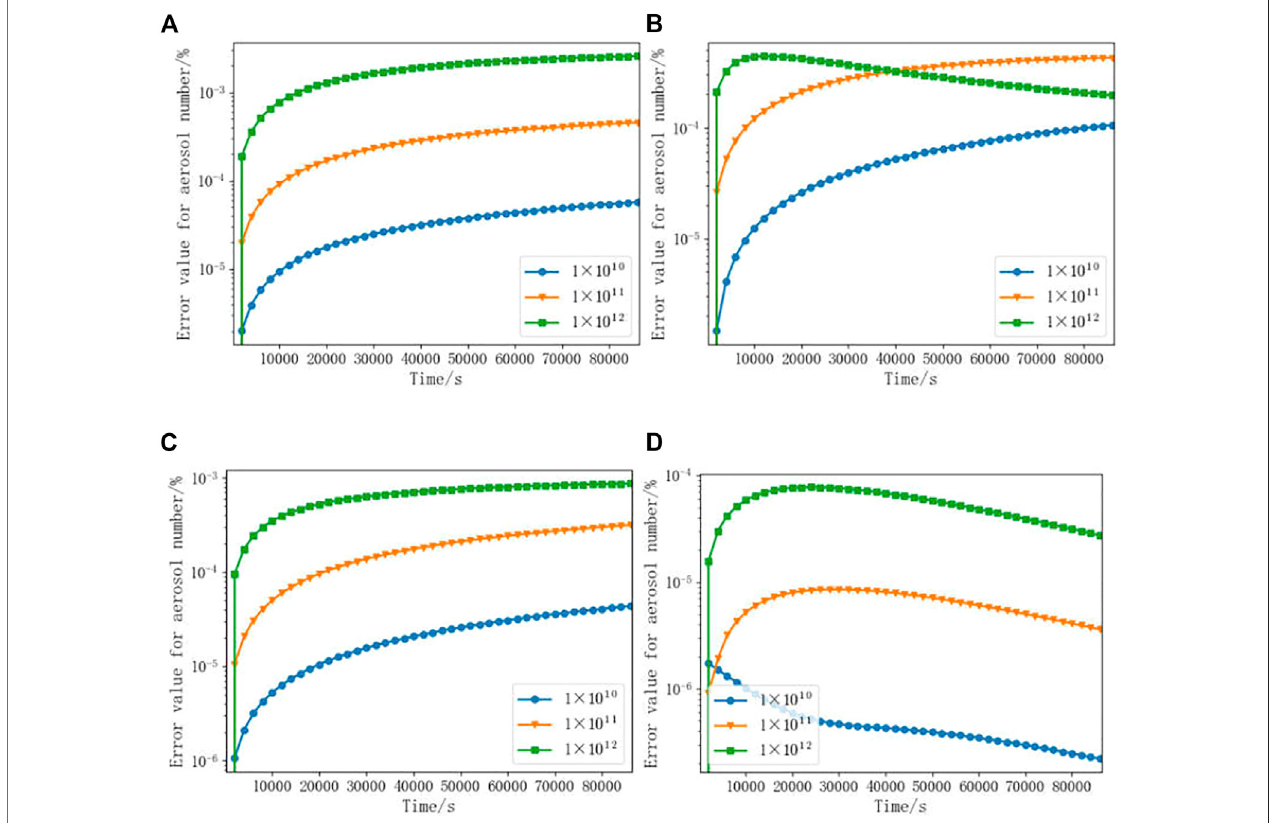
FIGURE3| Error value for the number of radioactive aerosols for different initial particle numbers. [ (A) , Constant coagulation kernel; (B) , linear coagulation kernel; (C) , constant coagulation kernel and the constant deposition rate of particles; (D) , linear coagulation kernel and the constant deposition rate of